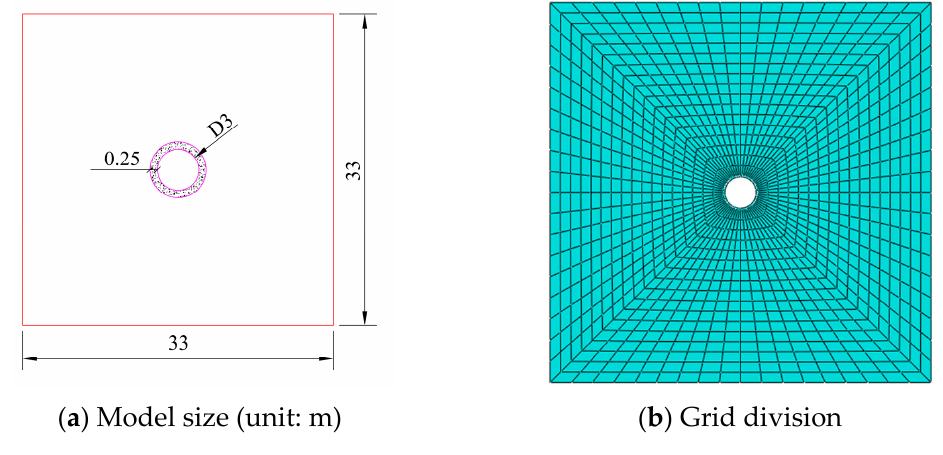
Figure 2. Numerical simulation model.